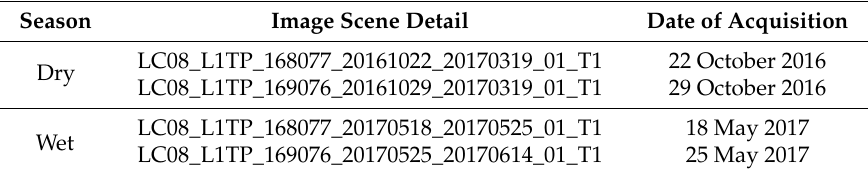
Table 1. Summary detail of the Landsat 8 OLI used for this work.